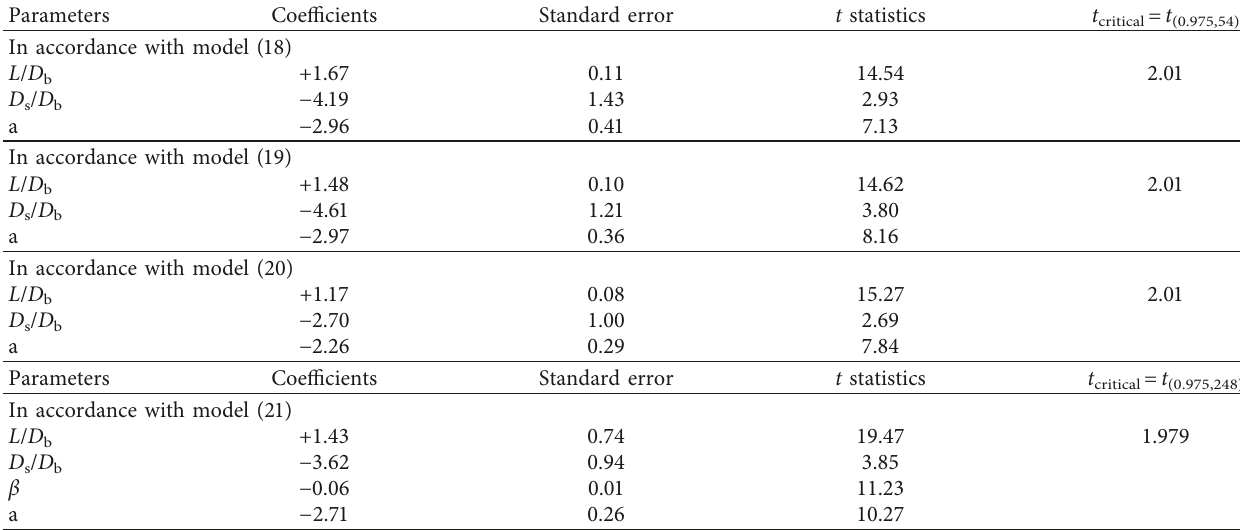
Table 5: Independent variables, coefficients, standard error, t statistics , and t critical of all the parameters from models (18) to